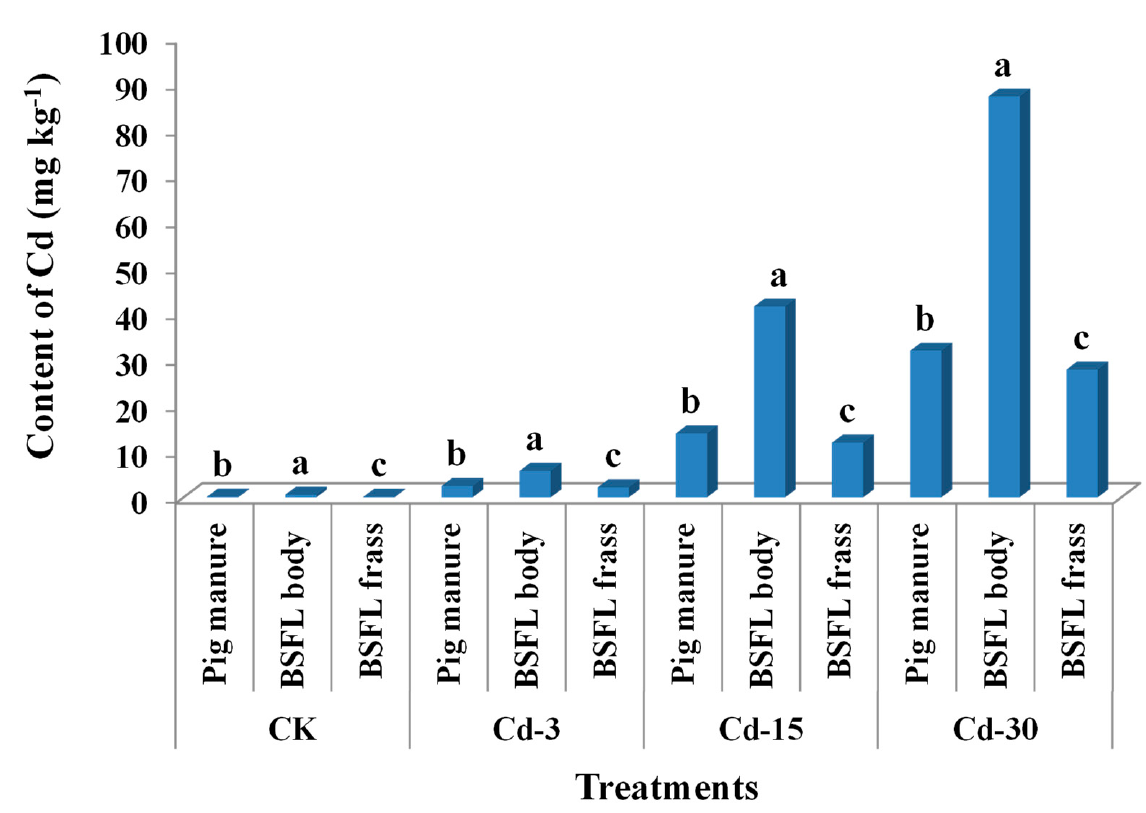
Figure 1. Contents of Cd (mean ± SE, n = 3) in pig manure, BSFL bodies, and BSFL frass under differ- ent treatments. Different letters denote significant difference at p < 0.05 under the same treat- ment.